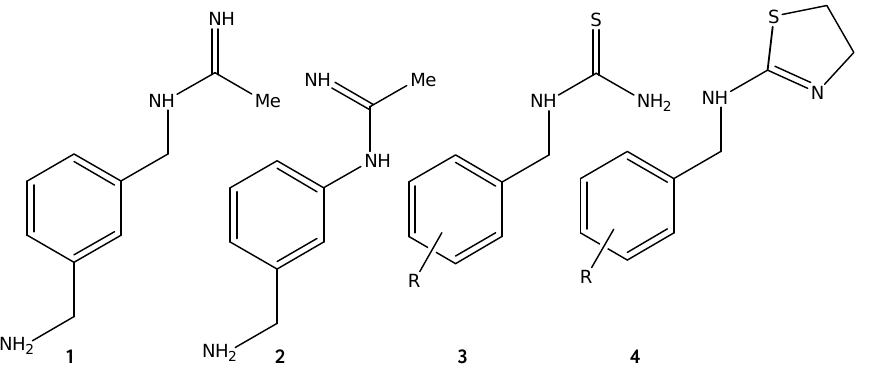
, 4-NH , 3-CO H, 4-CO 2 2= 2 2